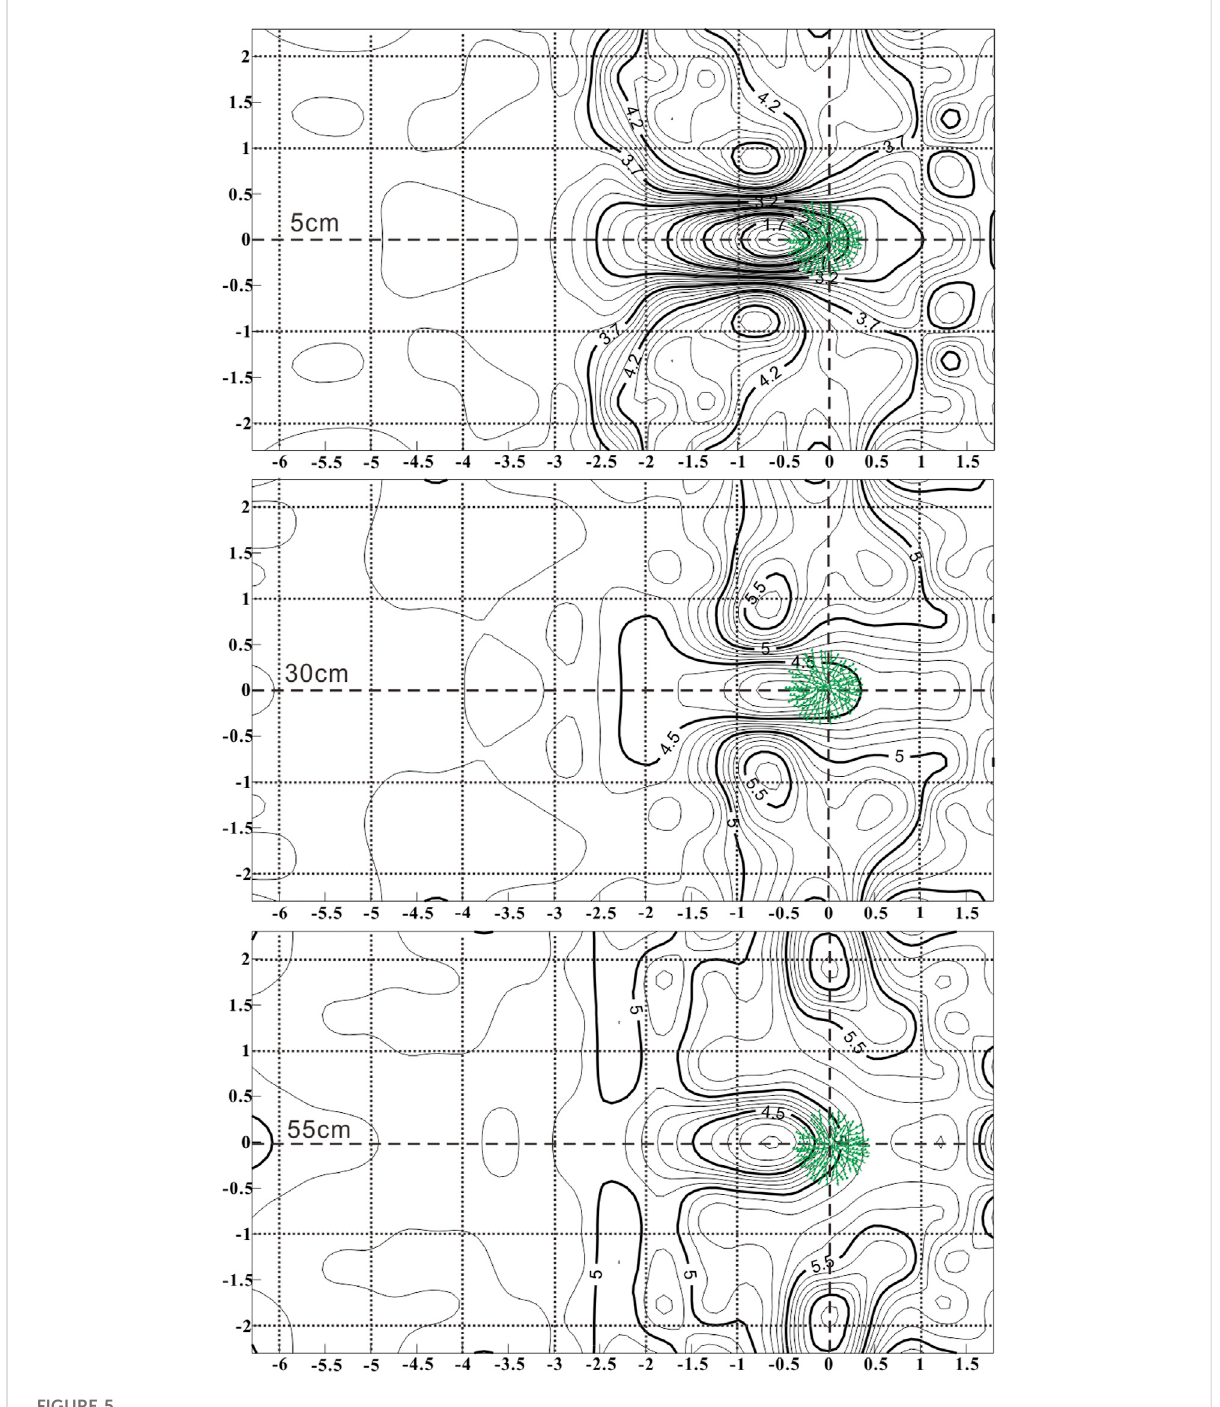
FIGURE 5 Air fl ow fi elds at three heights around an individual Artemisia ordosica